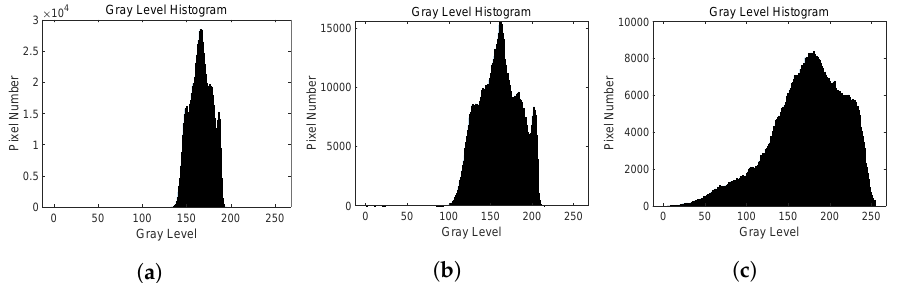
Figure 9. The gray level histogram of the original images and the dehazed images. ( a – c ) are the gray level histograms of Figure 8a–c,